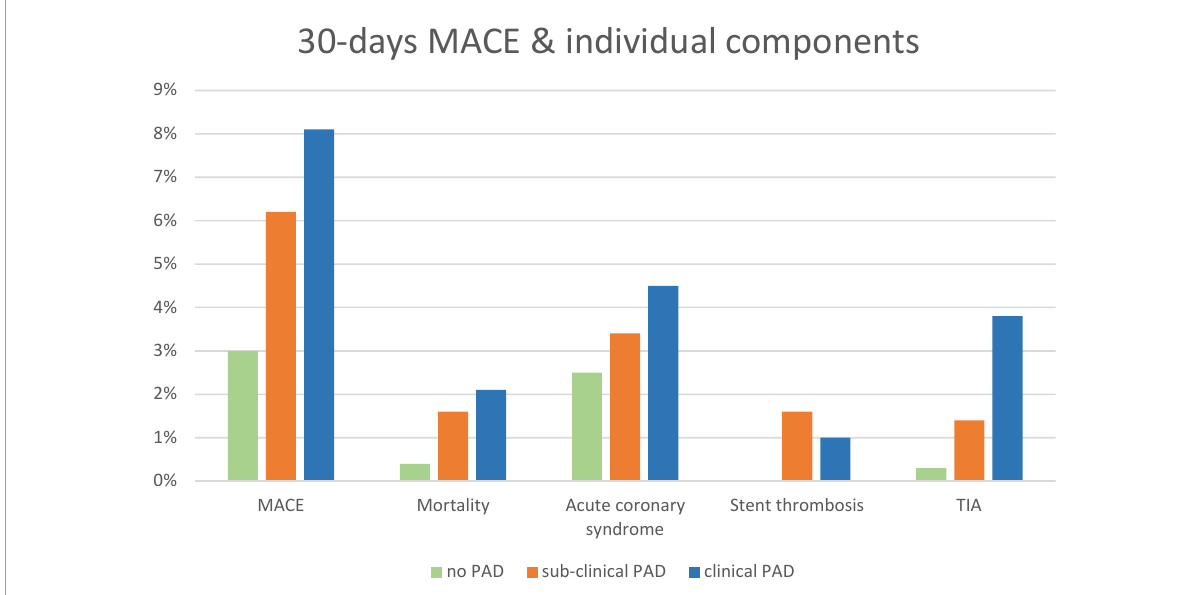
FIGURE2 A 30-day MACE, individual components, and bleeding according to pre-specified groups: no-PAD (green), subclinical PAD (orange), and clinical PAD (blue). MACE, major adverse cardiovascular event.